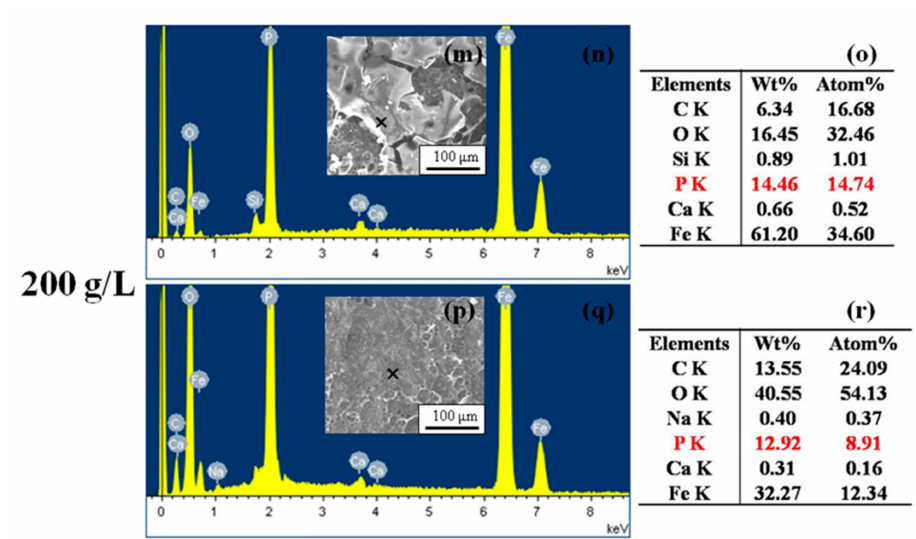
Figure 8. The surface morphology and EDX results of the rust treated by the rust converter: ( a , g , m ) the conversion layer, ( b , c )( h , i )( n , o ) the relative EDX results respectively; ( d , j , p ) the failure substrate, ( e , f )( k , l )( q , r ) the relative EDX results respectively.